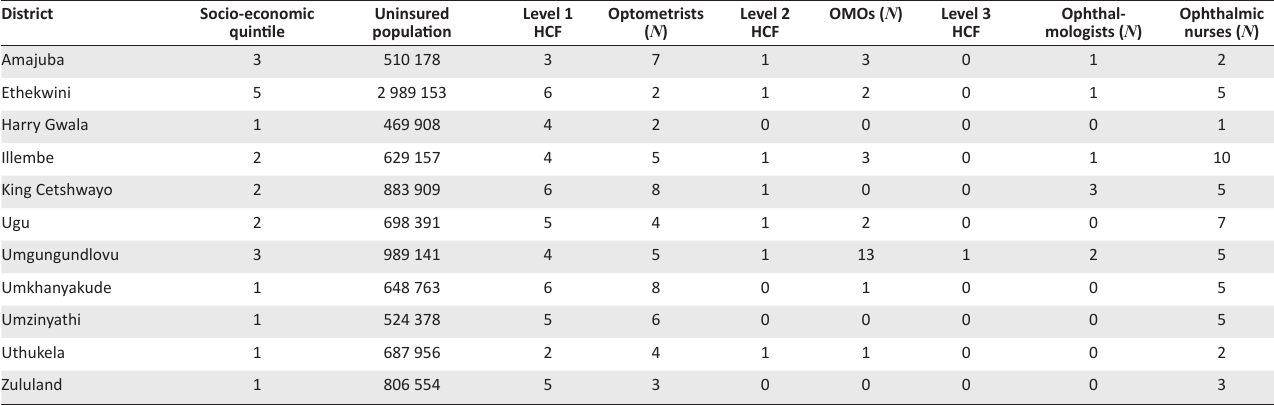
TABLE 5: A summary of staffing within the KwaZulu-Natal health facilities showing population size, hospital types and human resources for eye health across the province. District Socio-economic quintile